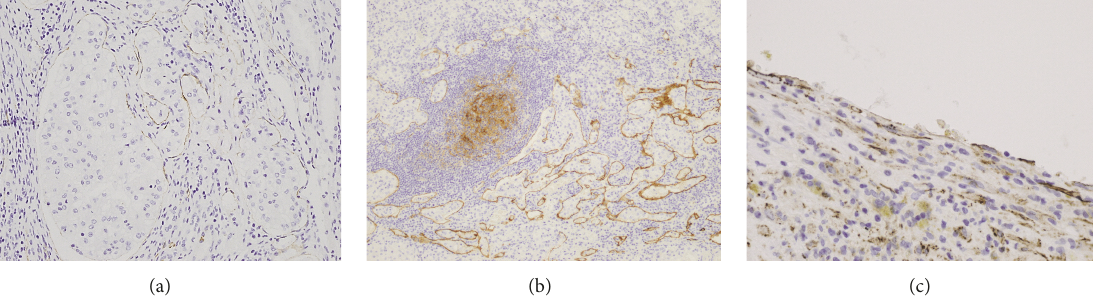
Figure 3: Immunohistochemical findings showing many lymphatic ducts expressing D2-40 filled with cancer nests in the kidney (a) and lymph node (b) and the coated cell of the cystic wall expressing D2-40